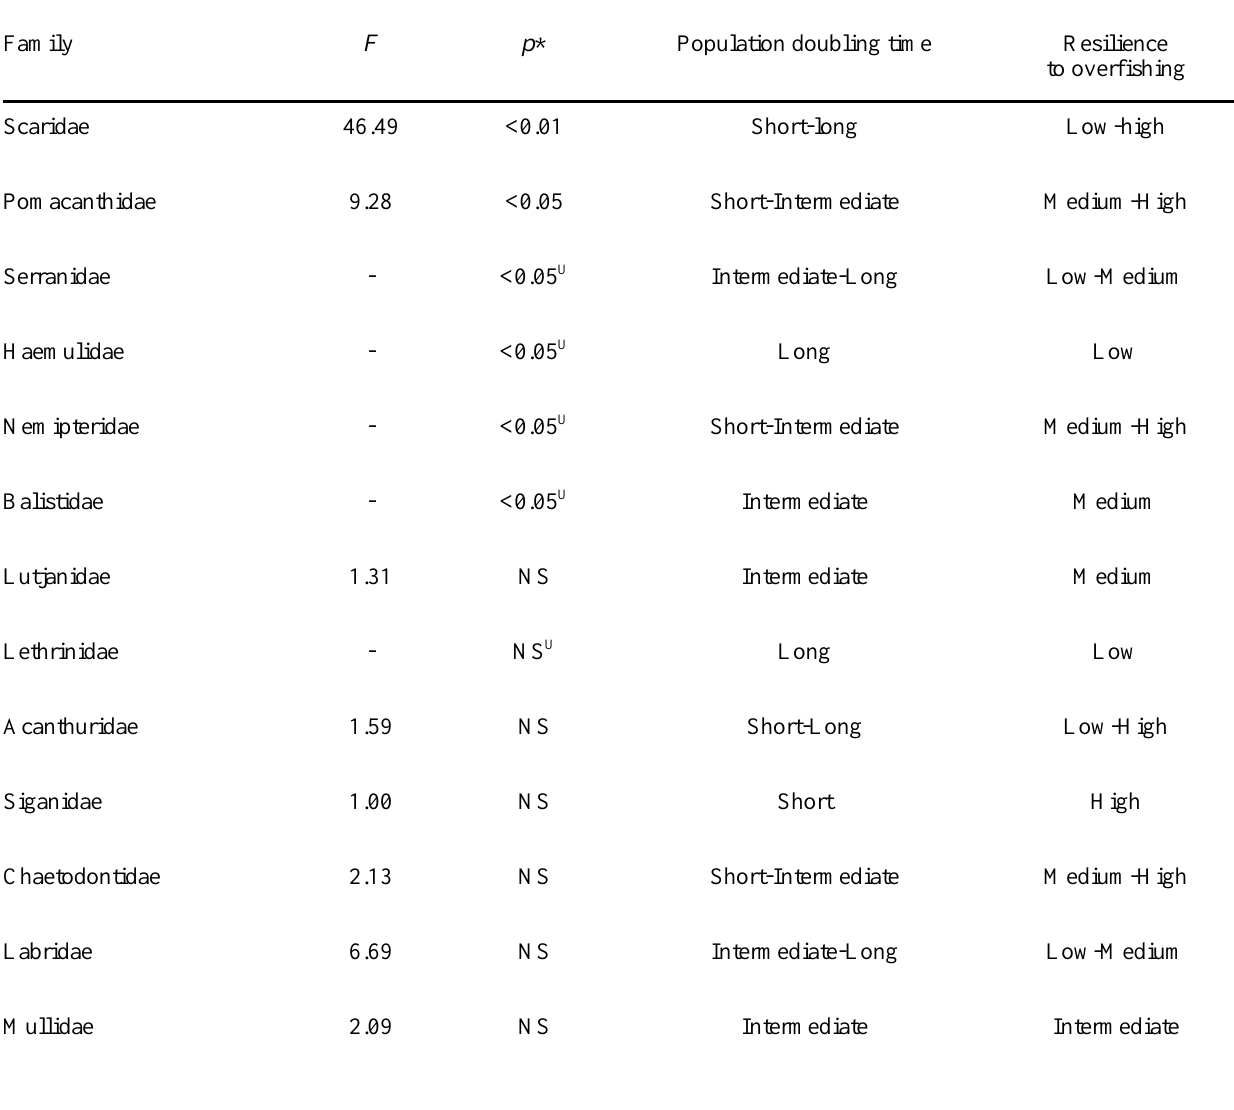
Table 3. Kakarotan: Results of the one-way ANOVAs for comparisons of biomass, inside vs. outside closures, life histories, and a summary of life histories and resilience to overfishing. Adapted from Froese and Pauly (1995) for families commonly caught in subsistence Indo-Pacific